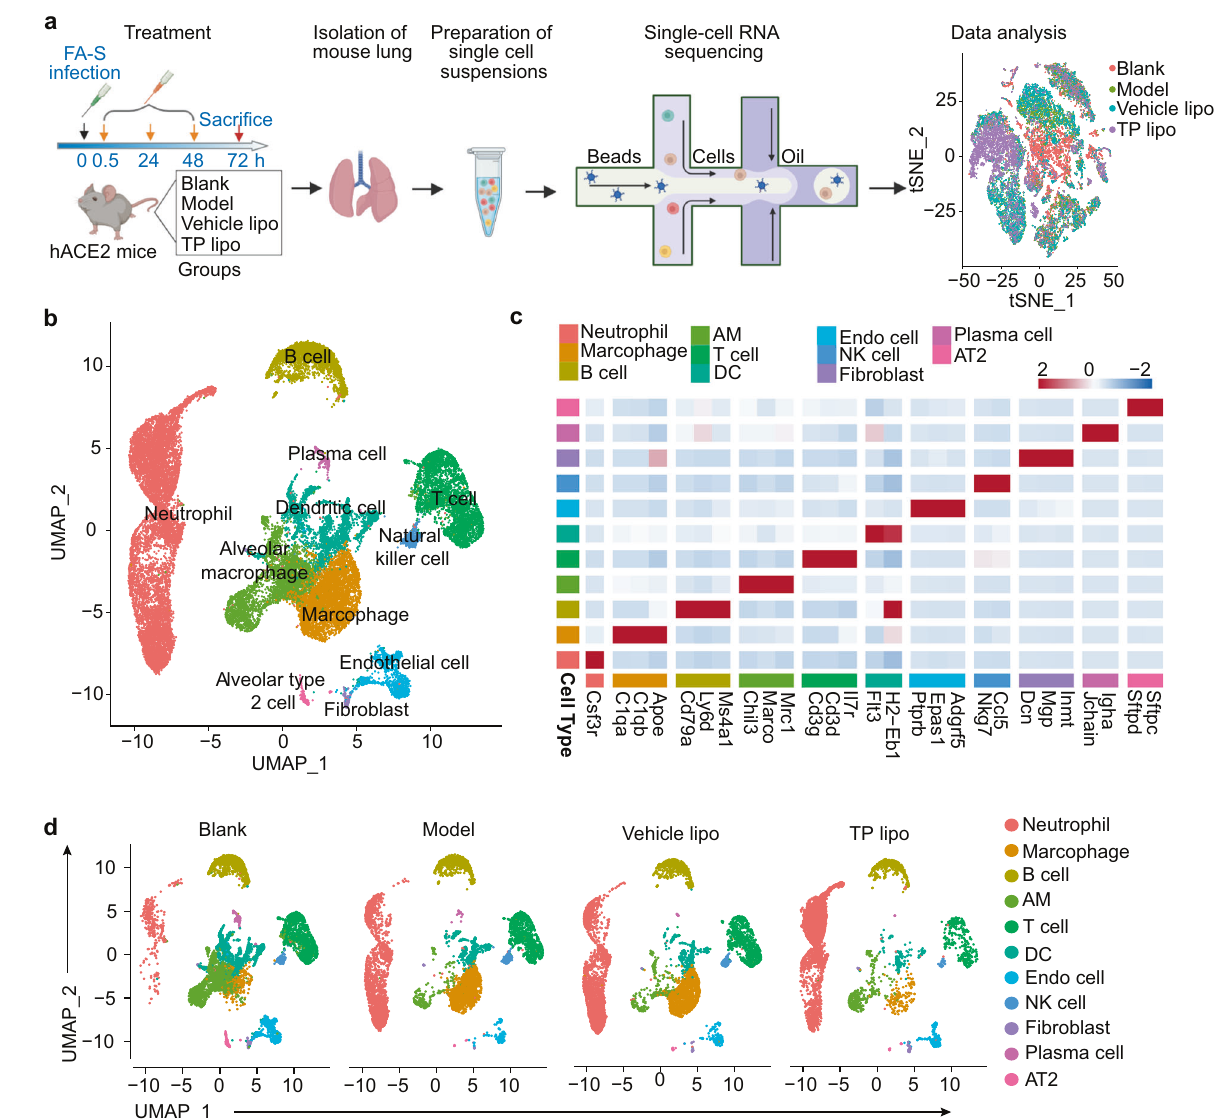
Fig. 4 scRNA-seq analysis of pulmonary cell clusters in treated mice. a Schematic illustration of the treatment strategy, lung dissociation, single-cell preparation, and scRNA-seq sequencing and analysis. b UMAP plot of 28229 cells from Blank, Model, Vehicle lipo, and TP lipo mouse testes. The number of cells in each cluster: Neutrophil (9308), Macrophage (3932), B cell (2977), AM (3592), T cell (3499), DC (2676), Endo cell (1226), NK cell (429), Fibroblast (220), Plasma cell (193), and AT2 (177). c Heatmap of the top transcripts in each cluster showed clear demarcation between different clusters. d UMAP plots showing the dynamic changes in all cell clusters in the lung among each group 11 cell clusters were identi fi ed (Fig. 4b). Based on Supplementary cells in BALF at 3 dpi showed that 1.5 mg/kg TP lipo suppresses Fig. S2a, the four experimental groups showed equivalent cellular the in fi ltration of neutrophils into alveoli in LPS-induced ARDS distributions and no enriched populations for batch variation or mouse models (Supplementary Fig. S1h). Furthermore, in TP lipo- technical variation. Generally, the top three cell types in mouse treated mice, total protein and LDH release in BALF were lungs were neutrophil (9308), macrophage (3932), and alveolar signi fi cantly lower than in untreated or Vehicle lipo-treated mice macrophage (AM) (3592) (Fig. 4b). Genes associated with particular (Supplementary Fig. S1i, j). These results revealed that TP lipo has cell types were used to annotate clusters of cells, as indicated by a strong antiin fl ammatory ability in viruses and bacteriotoxin- the gene expression heatmap (Fig. 4c). Mean expression patterns of induced ARDS. key signature genes, such as Csf3r (Neutrophil), C1qa (Macrophage), Cd79a (B cell), Flt3 (Dendritic cell, DC), Macro (AM), and Cd3g (T cell), Pulmonary cell types in hACE2 mouse ARDS revealed by scRNA- were also projected on the UMAP plot (Supplementary Fig. S2b). seq Compared with the Model and the Vehicle lipo groups, it was Pulmonary single cells from the four groups were collected 72 h clearly evident that TP lipo reduced neutrophil and macrophage after FA-S infection. The immune response to FA-S infection and TP recruitment to the lungs and increased AM cell residence in them lipo treatment was assessed by scRNA-seq (Fig. 4a). Using the (Fig. 4d). Thus, TP lipo may alleviate pulmonary in fl ammation by graph-based method and uniform manifold approximation and changing the lung immune microenvironment. projection (UMAP), 28,229 cells from four groups were plotted, and Signal Transduction and Targeted Therapy (2022)